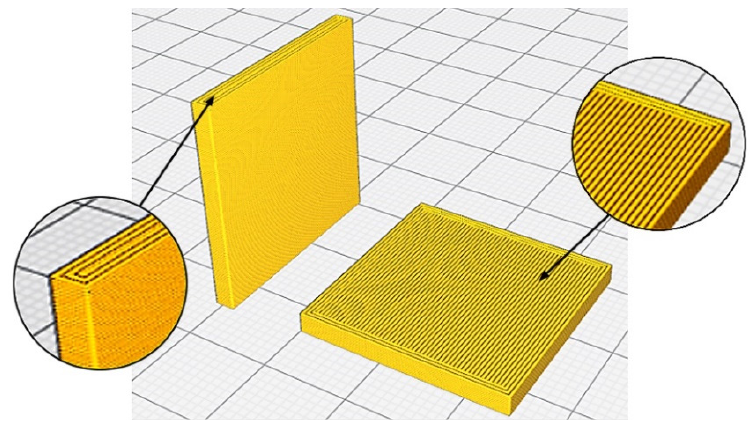
Figure 1. Print orientation: vertical (XZ) ( left ), and horizontal (XY) ( right ).